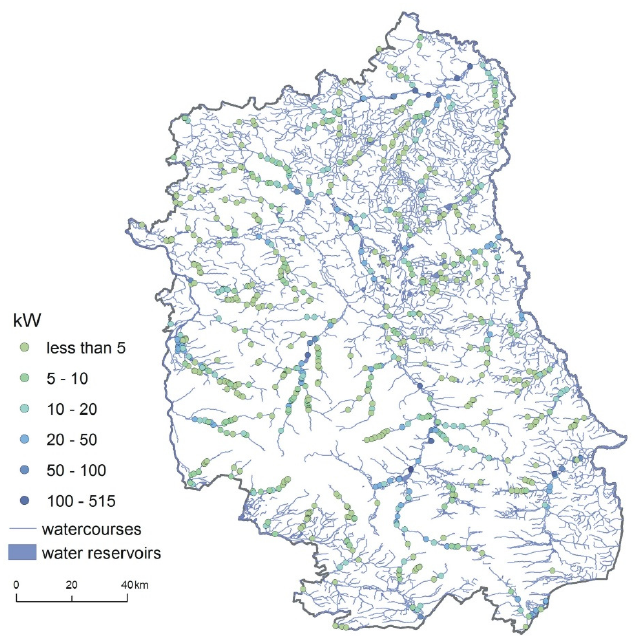
Figure 7. Localization of water dams and power of the potential hydropower plants in the Kujawsko-Pomorskie voivodeship (own elaboration). The power of all the potential hydropower plants in the Lubelskie voivodeship on dams is 9.0 MW (Figure 8).